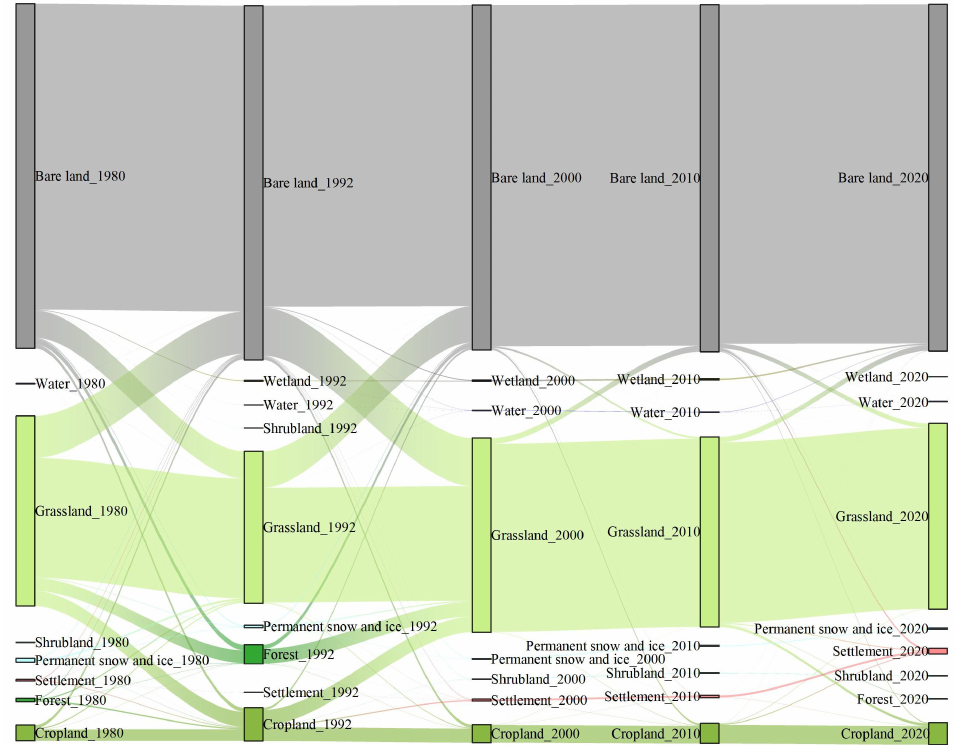
Figure 9. A Sankey diagram representing the transformation of reclassified land classes in the Turpan Basin from 1980 to